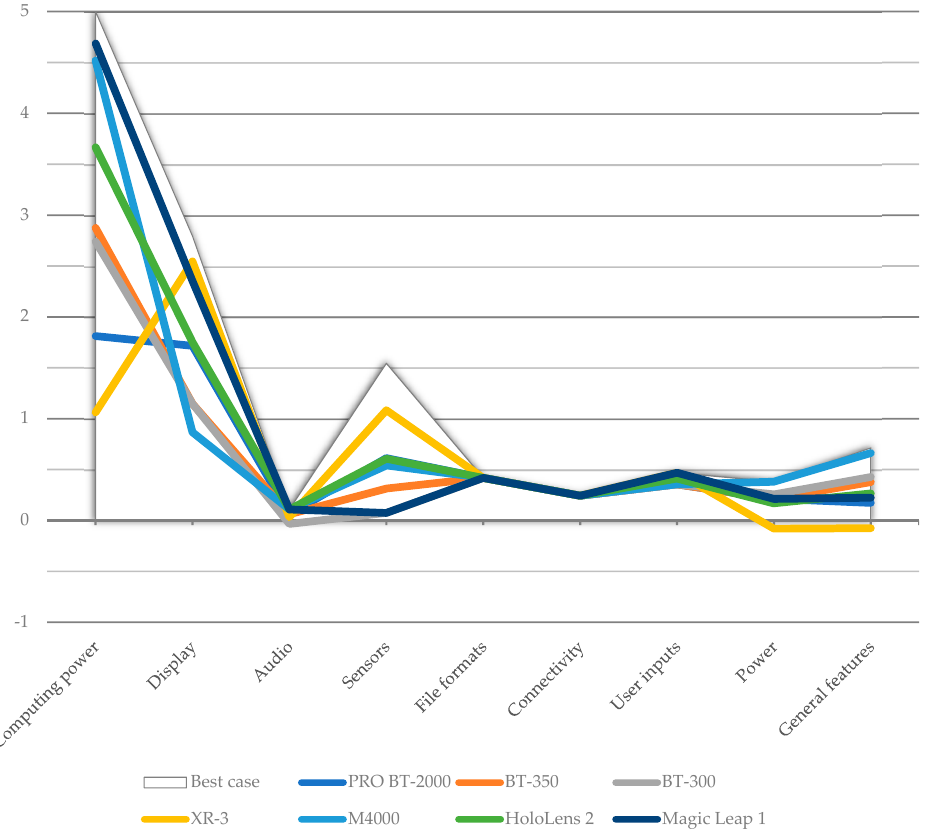
Figure 5 . Devices' evaluation chart for orthognathic surgery. Figure 5. Devices’ evaluation chart for orthognathic